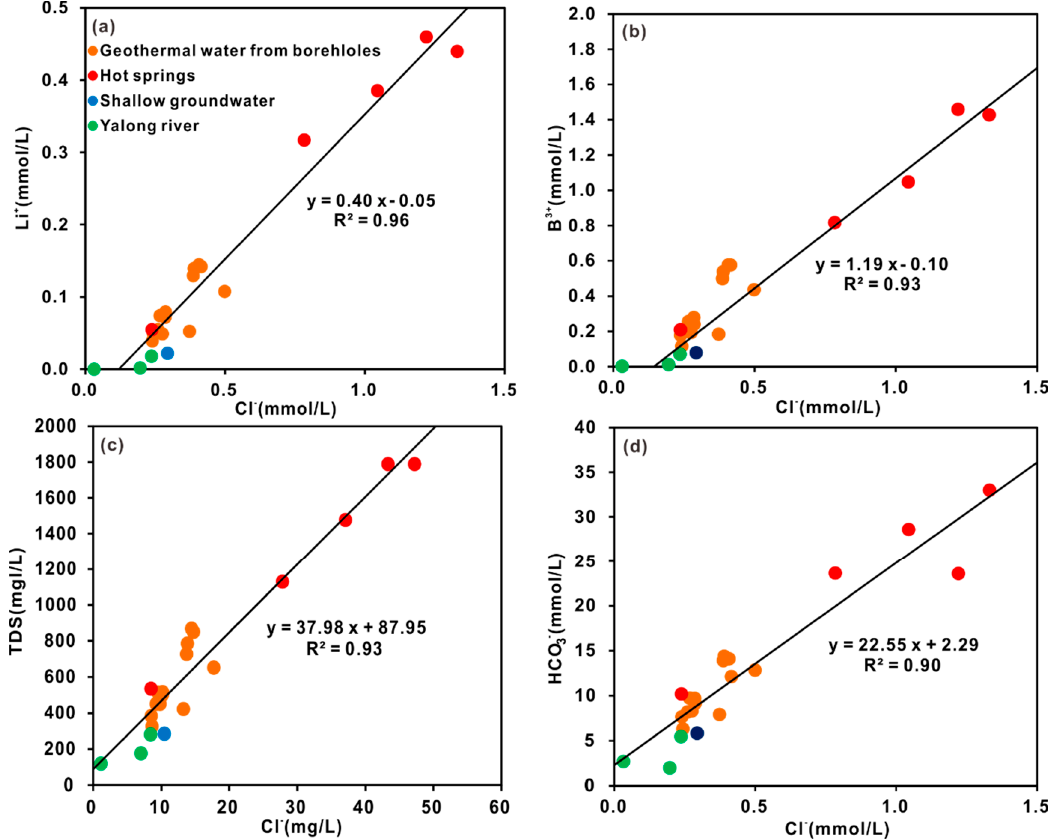
Figure 7. ( a ) Li + vs. Cl − correlation plot ( b ) B 3 + vs. Cl − correlation plot ( c ) total dissolved solids (TDS) vs. Cl − correlation plot, ( d ) HCO 3 − vs. Cl − correlation plot for water samples.